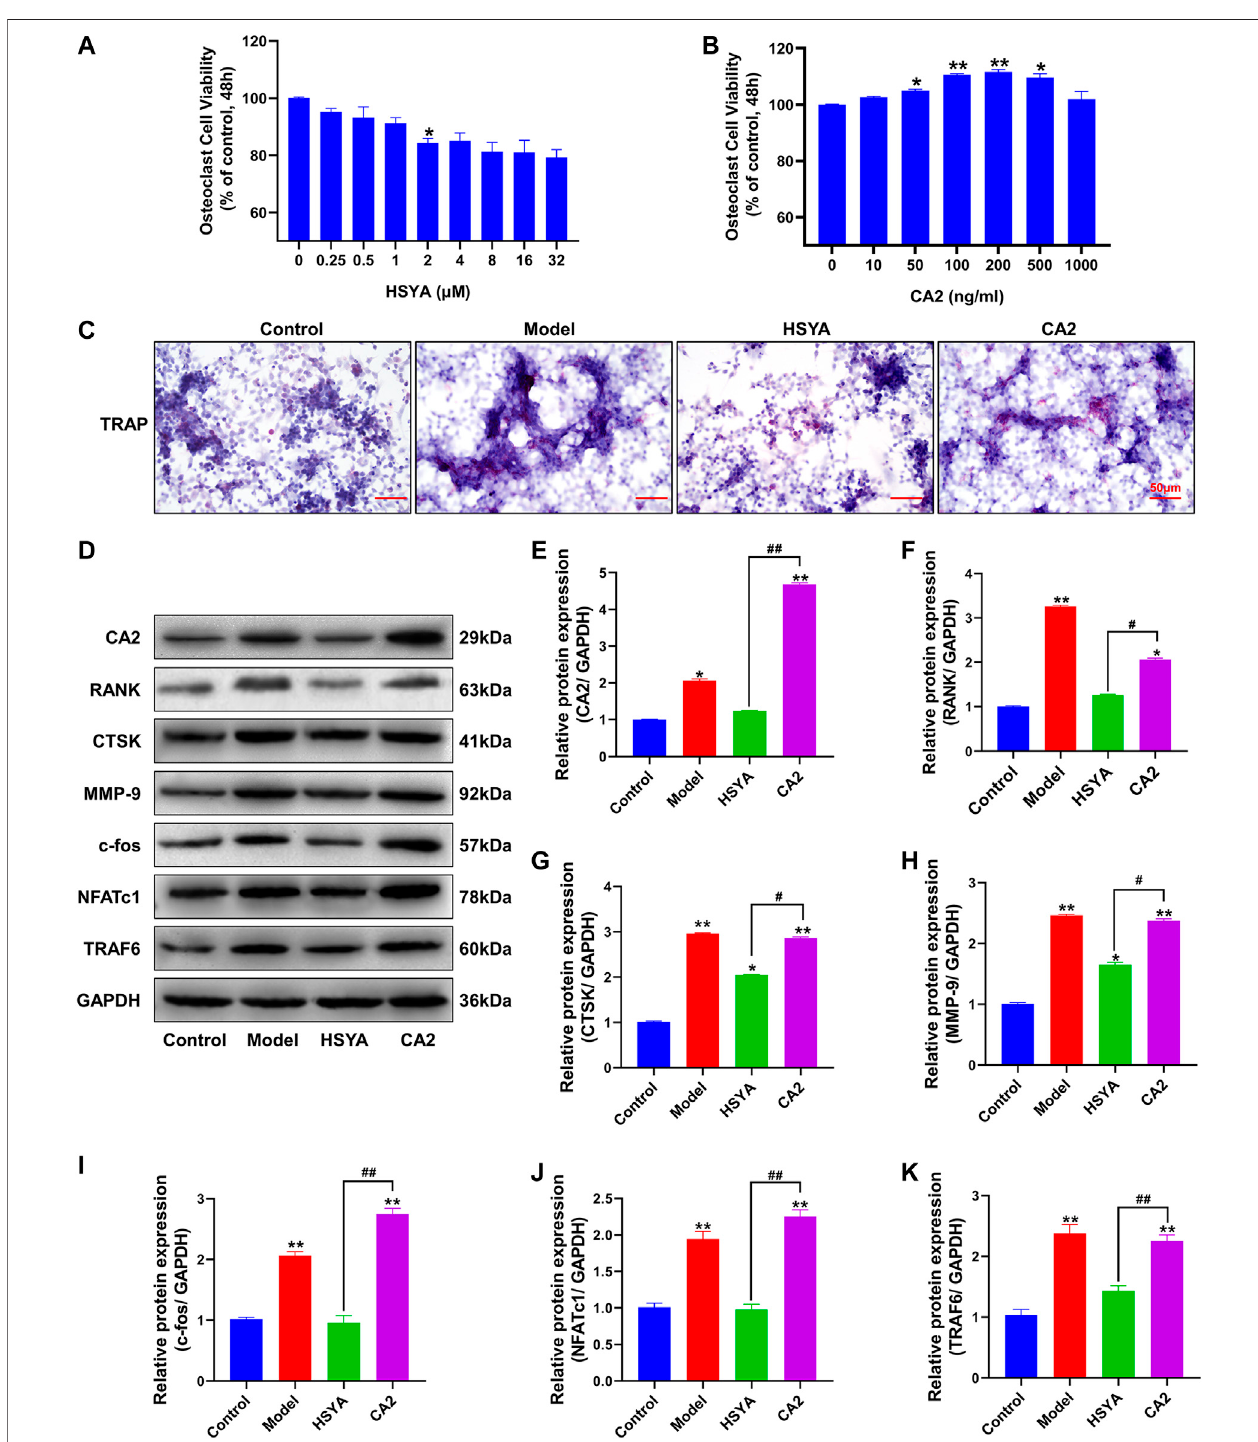
FIGURE 8 | HSYA regulates osteoclast differentiation of RAW264.7 cells through CA2. (A) An MTT was used to detect the effects of different doses of HSYA on RAW264.7 cells. (B) MTT was used to detect the effects of Different concentrations of CA2 recombinant protein on RAW264.7 cells. (C) TRAP staining results of RAW264.7cells. (D) TheexpressionlevelsofCA2,RANK,CTSK,MMP-9,c-fos,NFATc1,andTRAF6proteinsweredetectedbywesternblotting. (E – K) Thegrayvalues ofCA2,RANK,CTSK,MMP-9,c-fos,NFATc1,andTRAF6proteinswerequanti fi edbyImageJsoftware.Comparedtothecontrolgroup, “ ** ” indicates p < 0.01, “ * ” indicates p < 0.05. The HSYA group was compared with the CA2 group, “ ## ” indicates p < 0.01, “ # ” indicates p < 0.05.